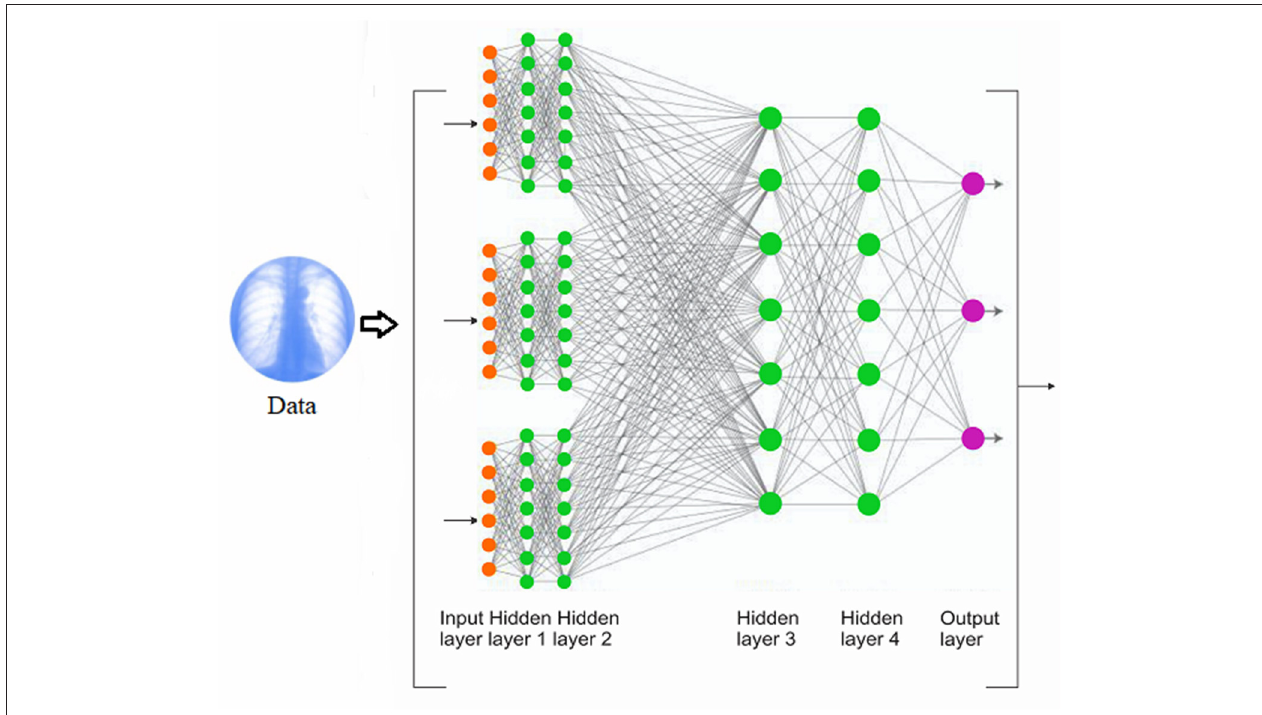
FIGURE 2 | The schematic pipeline of the training process of a convolutional neural